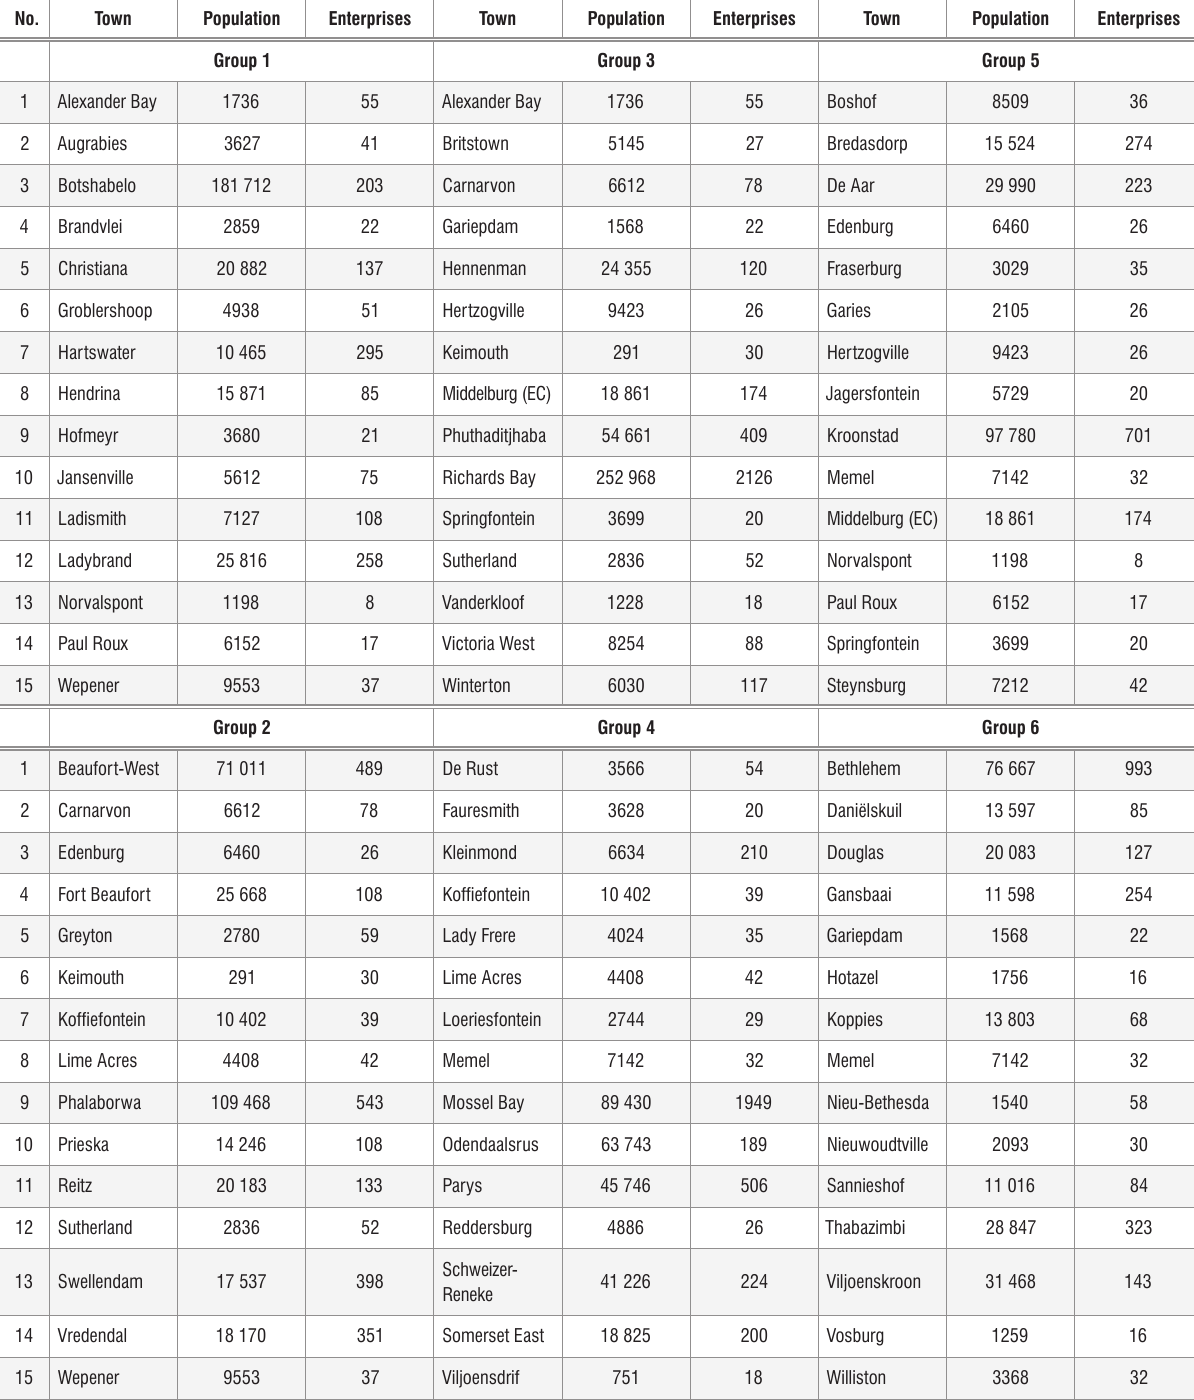
Six groups of 15 towns each randomly selected to examine their rank-size distributions